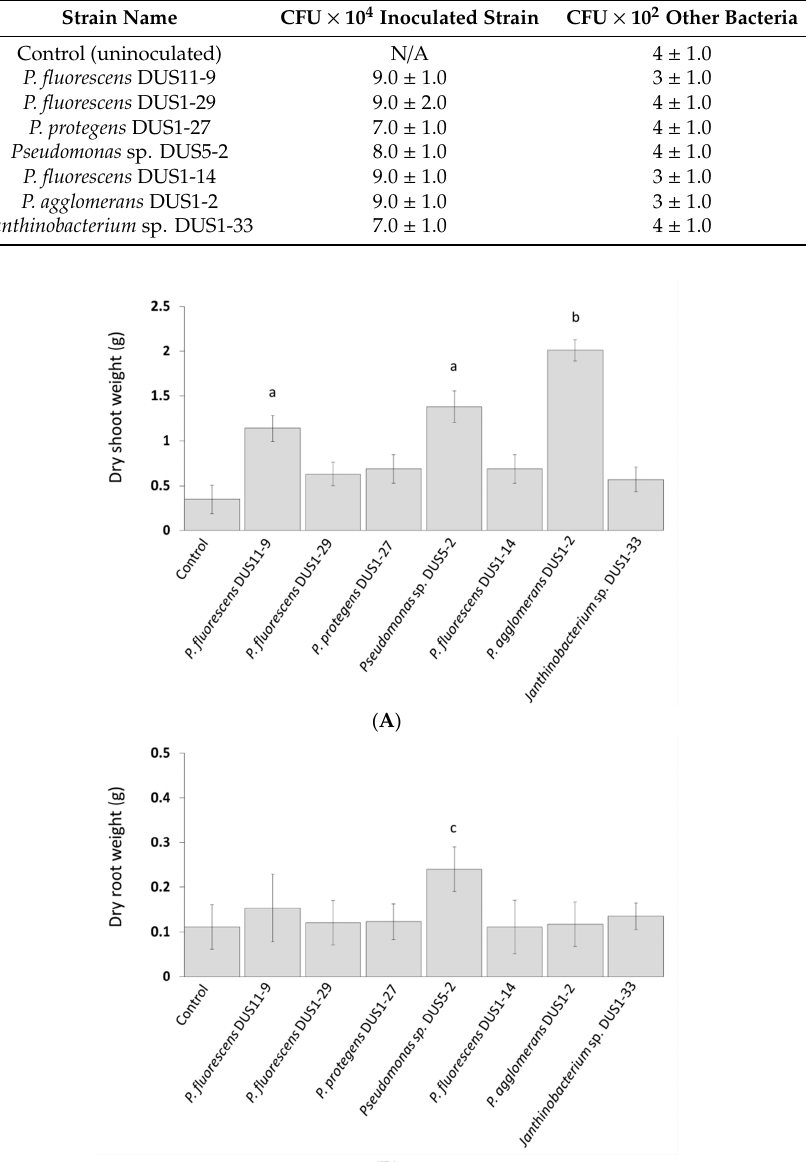
Figure 2. Effect of bacterial isolates on plant shoot ( A ) and root ( B ) biomass after 30 days in a laboratory based growth chamber at 22 °C, a low nutrient sand based medium supplemented with 50% Hoagland and Arnon solution and a controlled water activity of 3%. For each strain, 1 x 10 3 CFU of each strain was added when seeds were sown. “a” denotes significant ( p < 0.05) difference in dry shoot biomass for plants inoculated with P. fluorescens DUS11-9 and Pseudomonas sp. DUS5-2 compared to uninoculated control plants, and plants treated with other inoculants. “b” denotes significant ( p < 0.05) di ff erence in dry shoot biomass for plants inoculated with P. agglomerans DUS1-2 compared to uninoculated control plants, and all other inoculated plants. “c” denotes significant ( p < 0.05) di ff erence in dry root biomass for plants inoculated with Pseudomonas sp. DUS5-2 compared to uninoculated control plants, and all other inoculated